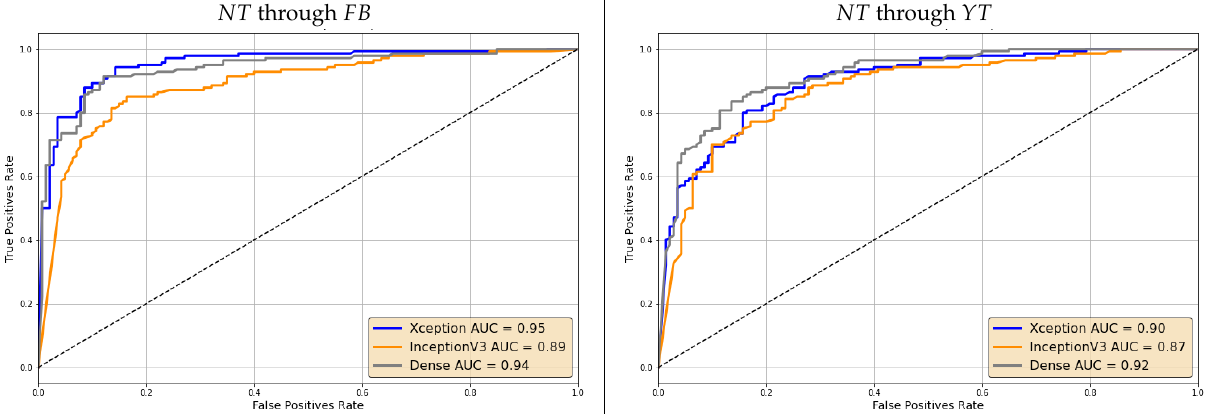
Figure 9. ROC curves of the video-based decision through specialized models on NT videos shared on Facebook ( left ) and YouTube ( right ).